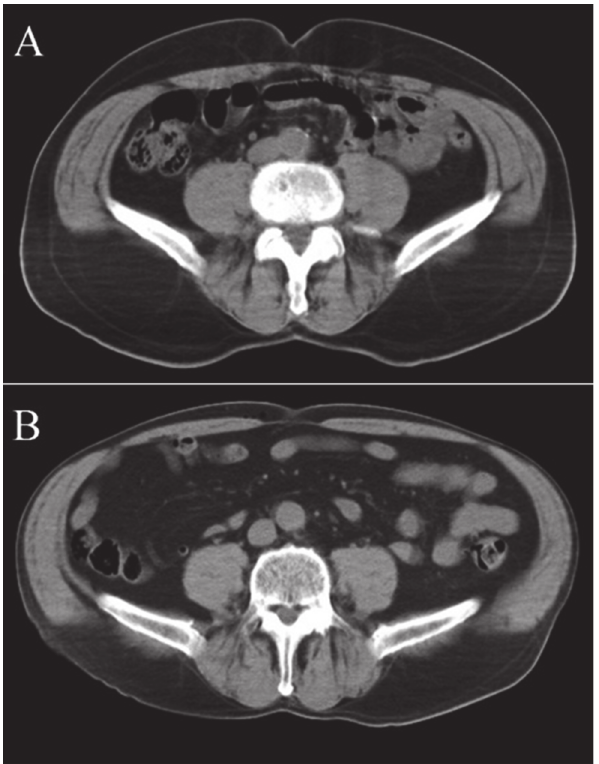
Fig 4. Patient examples with the same body mass index (BMI) and normal or increased ( > 188.4 cm 2 for men) areas of visceral adipose tissue (VAT). (A) Male, age 69 years, BMI 25 kg/m 2 , VAT area 80 cm 2 . (B) Male, age 71 years, BMI 25 kg/m 2 , VAT area 230 cm 2 .